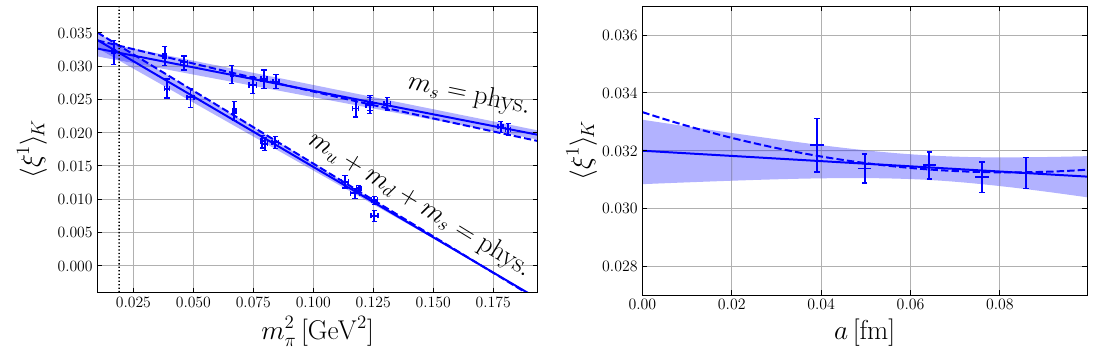
Figure 9 . Left: The same as figure 6, but for the moment been condensed into one plot. Right: The same as figure 7, but for the moment for the individual lattice spacings and trajectories can be found in figure 13 in appendix A.